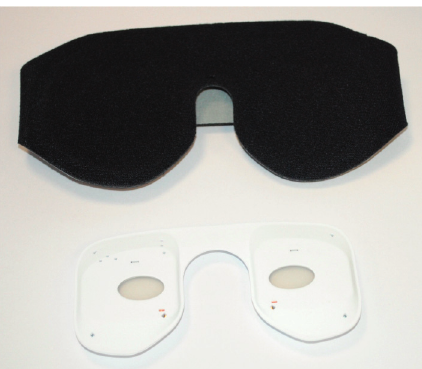
Figure 1: Picture of the black fabric mask and the white plastic pod housing the OLED lighting that make up Noctura 400.